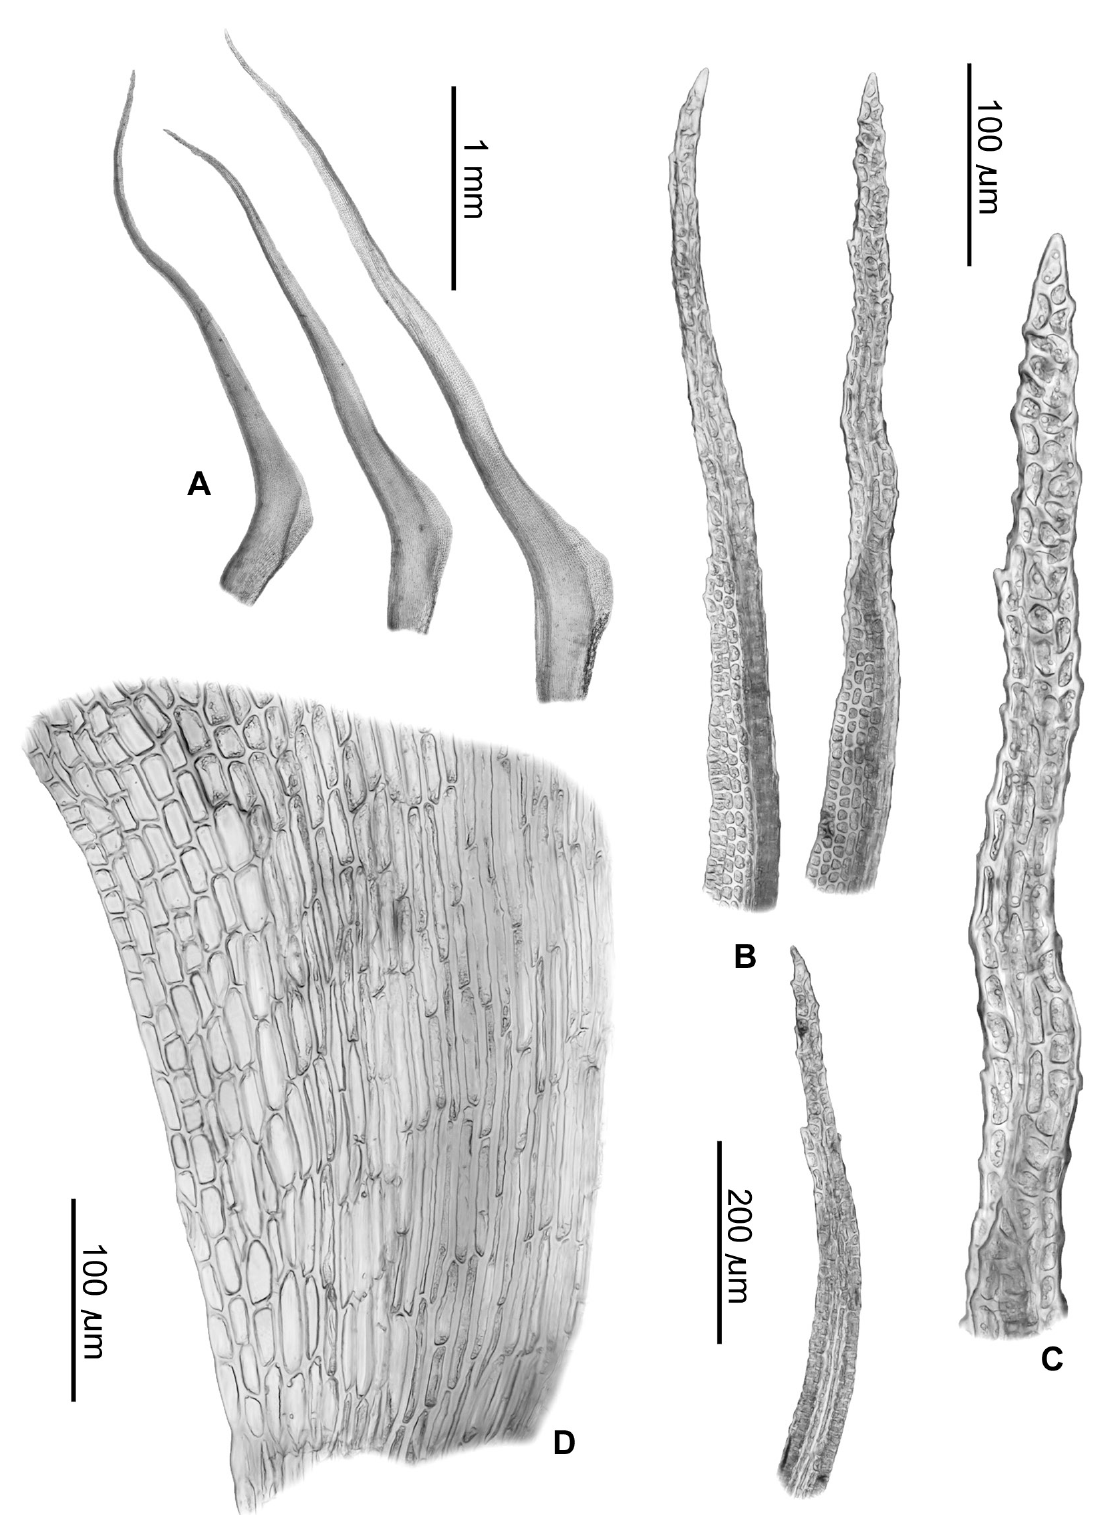
Fig. 8. Oncophorus wahlenbergii B (specimen P234; cf., Table 1). A . Stem leaves. B . Upper leaf acumen. C . Uppermost leaf acumen at higher magnification. D . Sheathing leaf portion, showing short marginal leaf cells and alar region (margin to the